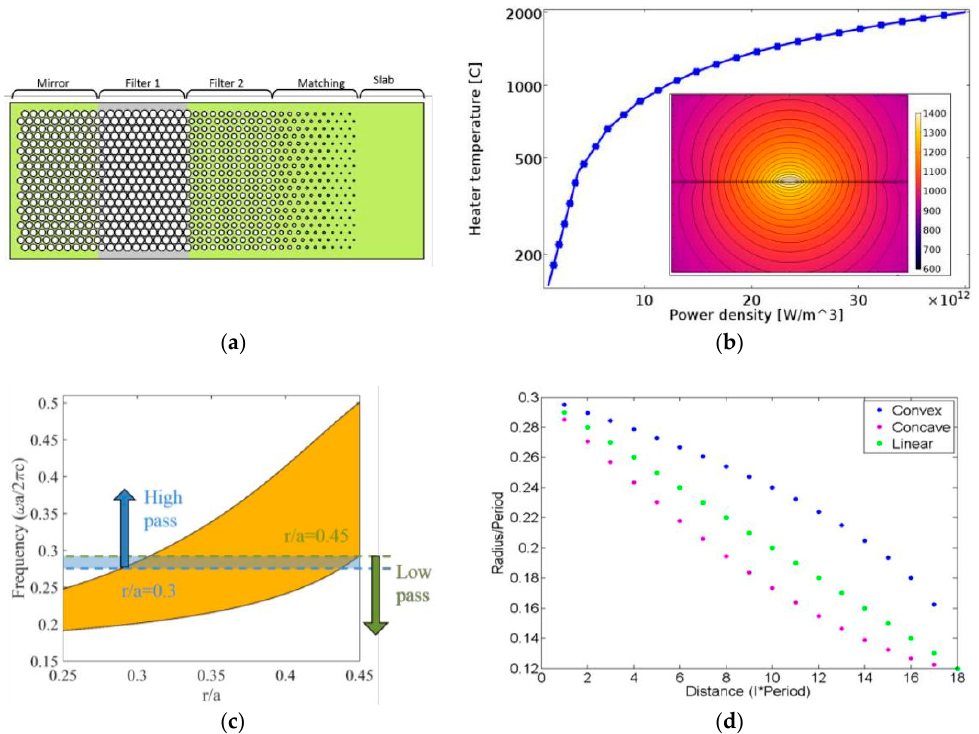
Figure 1. ( a ) Schematic representation of the 2D PhC thermal emitter, the green and gray shades corresponding, respectively to undoped and doped Poly-Si. ( b ) Temperature of the doped region as a function of the input power calculated considering the heat equation, photo-emissivity and laminar flow of air, inset: the temperature map at the cross section of the structure, color bar: the corresponding temperature. ( c ) Gap map of a PhC of holes in doped-Si as a function of the normalized hole radius for a periodicity of a = 1250 [nm]. Arrows up and down show the pass frequency range of the Filter 2 and 1 respectively. ( d ) The radii of the holes in the adiabatic region as a function of their distance from the beginning of the